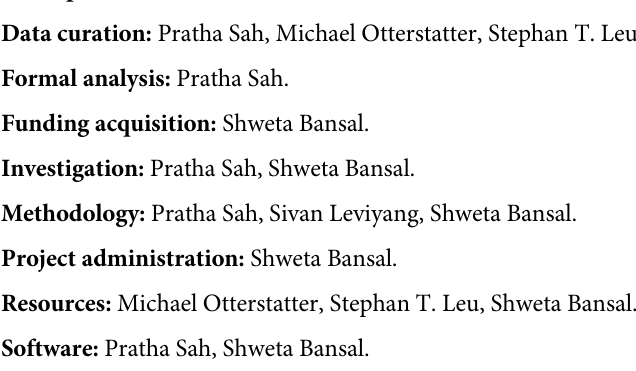
S4 Fig. Relative deviation of estimated � from the maximum possible value with increasing percentage of random missing data. Maximum � was determined by maximizing the likeli- hood function in Eq (2) assuming network with no edges. Each boxplot summarizes the results of 20 independent SI disease simulations through a synthetic dynamic network—two each for ten β � values ranging from 0.01 to 0.1 with increment of 0.01. Missing data were created by randomly removing 10–60% of nodes, edges or cases from the dataset. The middle black line in each box plot is the median, the boxed area extends from the 25th to 75th quartile, and whis- kers extended from the hinge to the largest/smallest value no further than 1.5 times the inter- quartile range. S5 Fig. Disease prevalence corresponding to different values of β used in our simulations for Fig